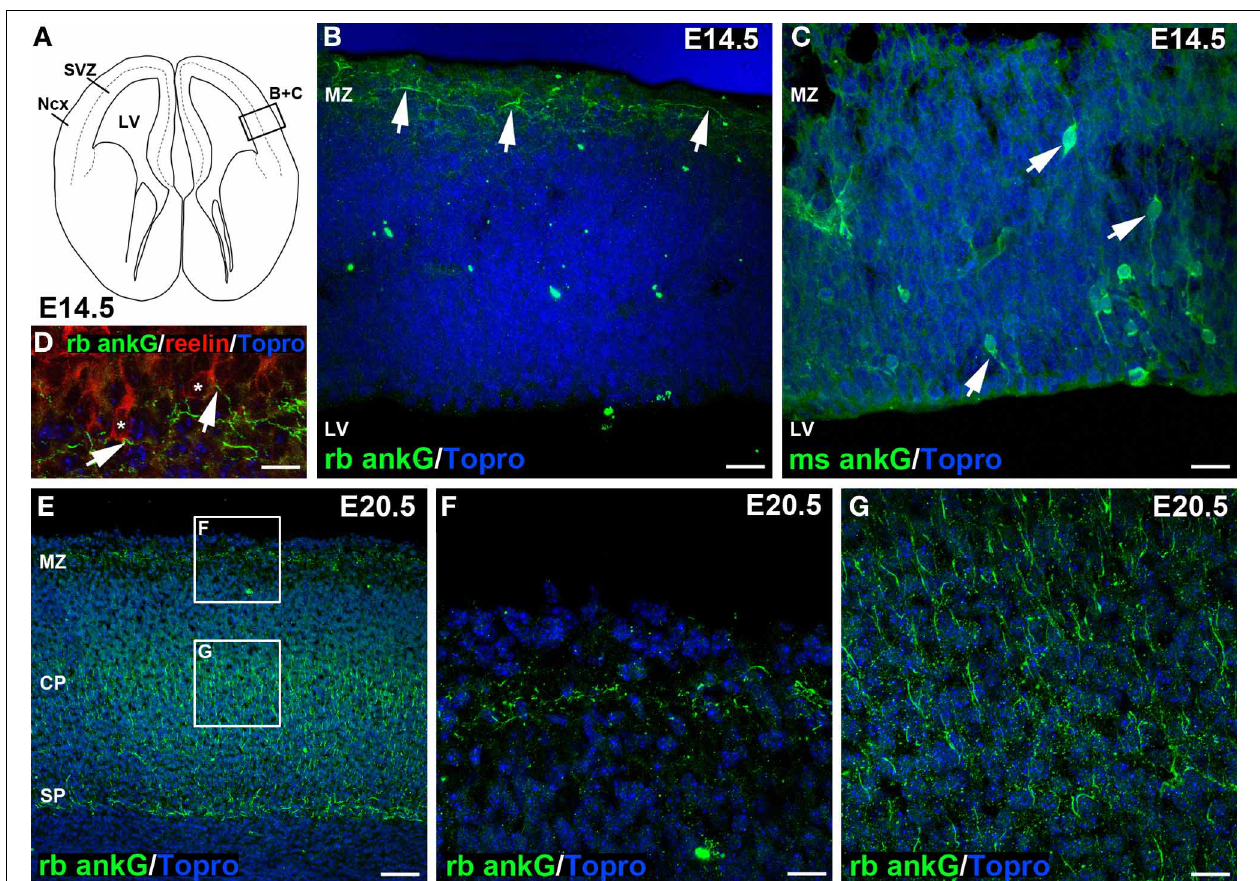
FIGURE 2 | Distinct ankG signal in embryonic sections at E14.5 and E20.5. (A) Line graph of an E14.5 coronal section of mouse brain, modified from Schambra et al. (1991). Box indicating (B) + (C) highlights region of interest depicted in (B,C) . (B) Distinct ankG immunosignal at E14.5 resulting from polyclonal rabbit antibody (green) was localized to AIS of putative Cajal-Retzius cells in the marginal zone (MZ, arrows), also shown in (D) . AIS appear predominantly horizontal along the pial surface of the cortex. (C) Somatodendritic ankG immunosignal resulting from usage of monoclonal mouse antibody (green) at E14.5. Cells appear mostly bipolar with processes extending from the soma (arrows). No AIS were observed at E14.5 with this antibody. (D) Reelin-positive